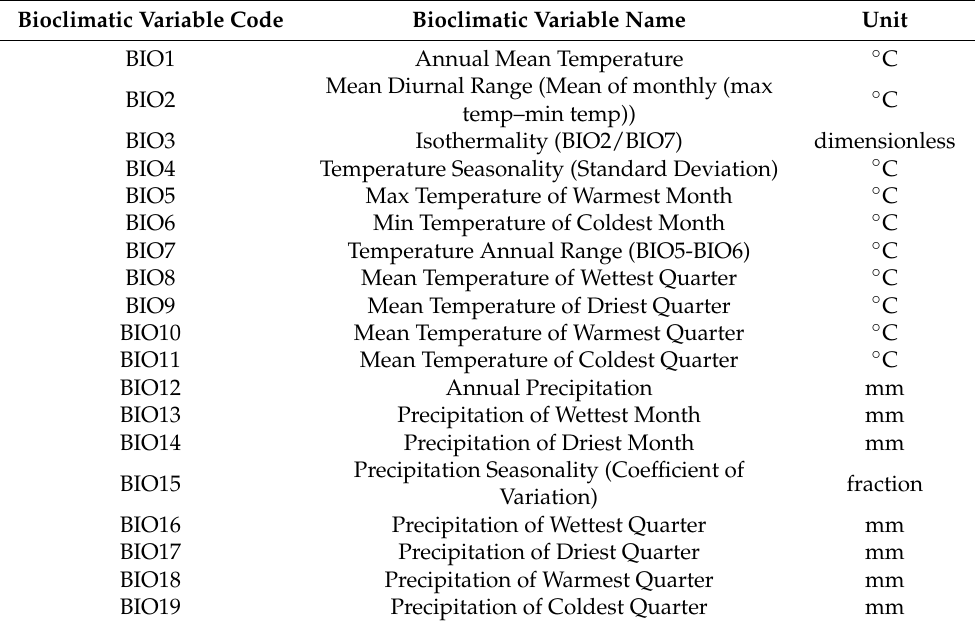
Table 1. Environmental variables used in the habitat suitability modelling